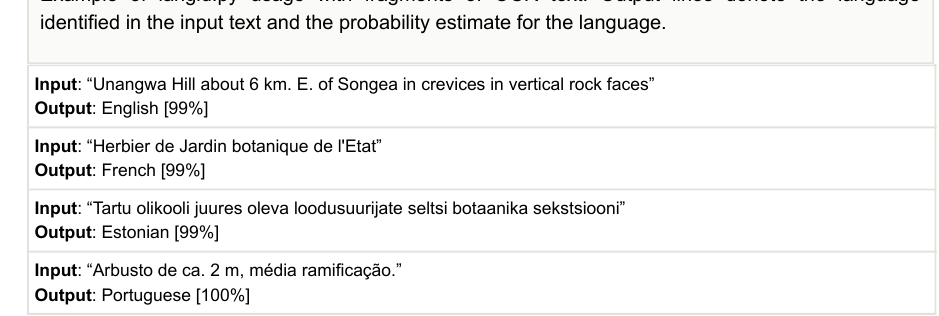
Example of langid.py usage with fragments of OCR text. Output lines denote the language identified in the input text and the probability estimate for the